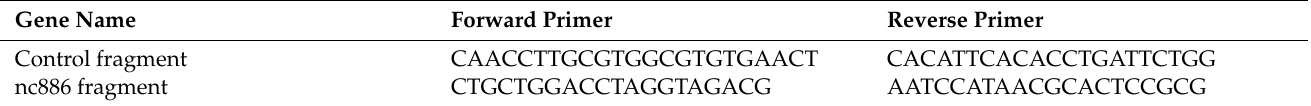
Table 2. Sequences of primers used DNA Transfection for